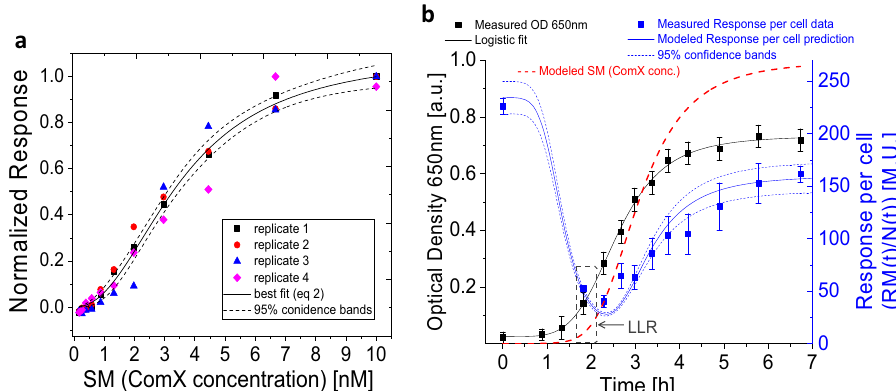
Fig. 4 In fl uence of oxygen on the presence of SM (ComX). a Signal molecule de fi cient B. subtilis PS-216 ( Δ comQ, P srfAA -yfp ) was incubated in the presence of SM for 4 h and the maximum normalized response was determined from the activity of the srfA promoter. n = 4 biologically independent replicates were performed. Best, concatenated fi t to the model in Eq. (2) is presented together with 95% con fi dence level. b the logistic fi t to one of the three growth curves ( n = 3, biologically independent replicates) measured as OD650 of the culture B. subtilis PS 216 ( srfA-lacZ ) producing signal molecule, SM that accumulated in the growth medium of batch system is shown. The response per cell data, obtained as the β -galactosidase activity of srfA promoter of B. subtilis PS-216 ( srfA-lacZ ) was fi tted by Eq. (3), ( R 2 > 0.99). The time interval at which SM concentration is high enough to cause the measurable response, i.e., lower limit of response (LLR) as predicted from data in experiments in ( a ) is given as dashed window in ( b ). One of the fi ve qualitatively and quantitatively similar experimental results is presented. Error bars represent SD of 8 technical replicates. For fi ts of additional replicates and data variability refer to Supplementary Tables 3 and